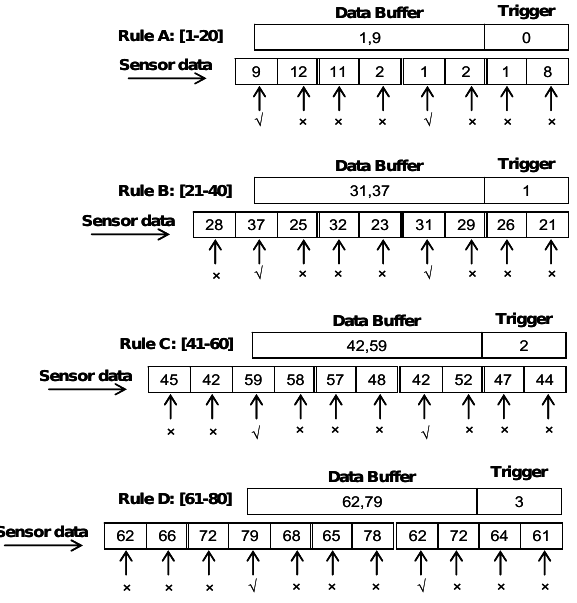
Figure 3. Data buff.ers management in